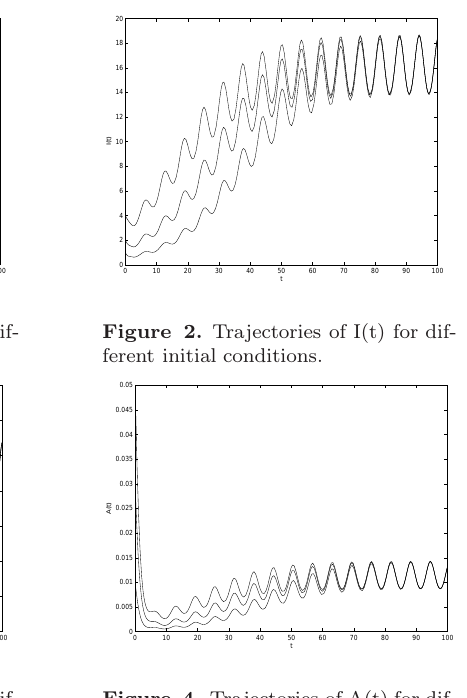
Figure 3. Trajectories of J(t) for dif- ferent initial conditions.